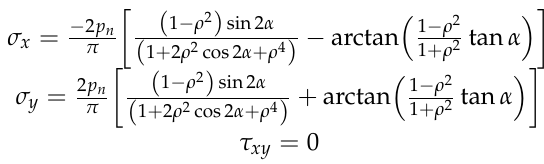
Figure 4. σ x contour map of the axial compression on the part boundary of the circular shaft.